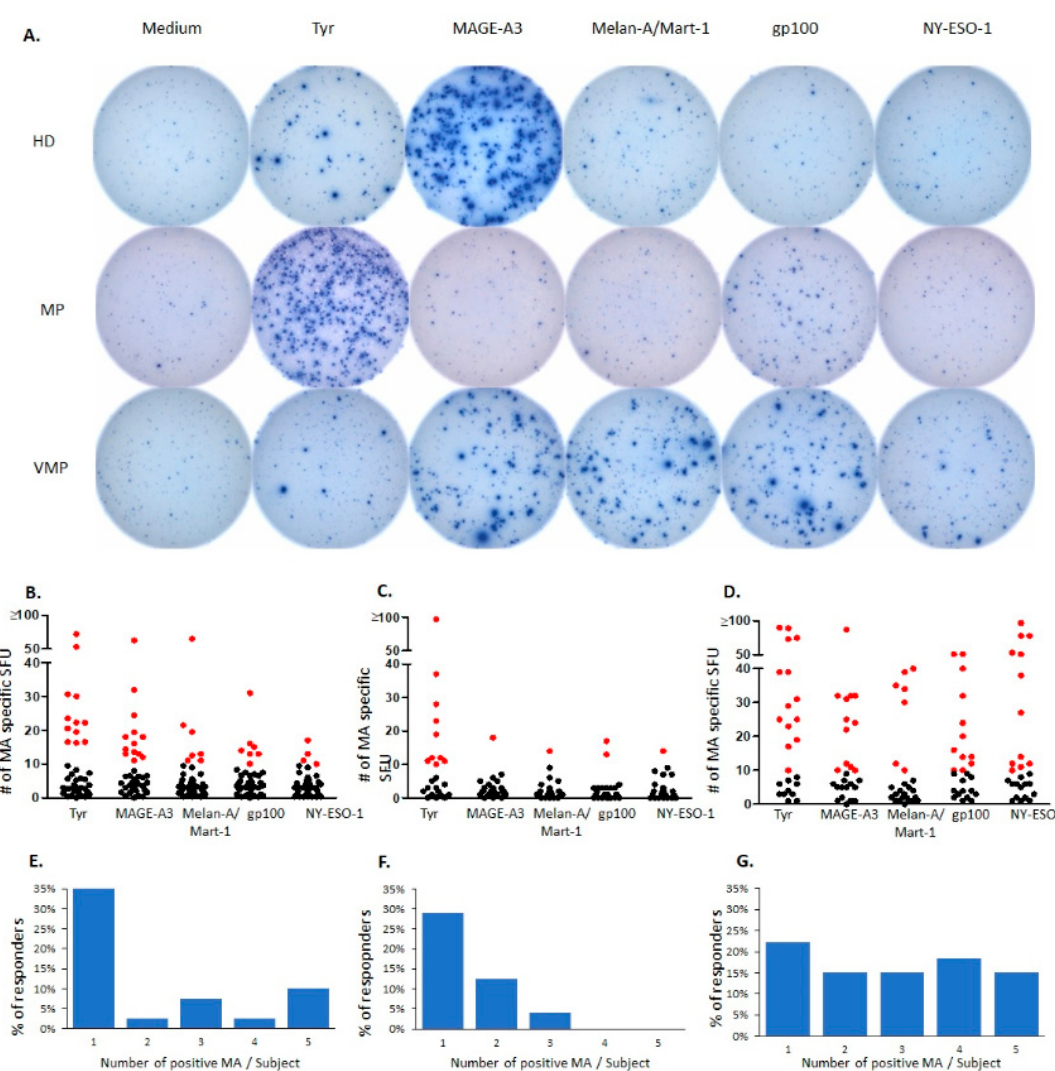
Figure 1. IFN- γ ELISPOT recall responses to melanocyte antigens. ( A ), Representative well images (96-well plate). The melanocyte antigens (MA) specified across the top were tested on PBMC of healthy donors (HD), untreated melanoma patients (MP), and MP vaccinated with AGI-101H (VMP). Well images are shown for a subject representative of each cohort. ( B – D ): The number of MA-specific CD8+ T cells in PBMC of 40 HD ( B ), 24 MP ( C ), and 27 VMP ( D ). For each subject, the IFN- γ ELISPOT recall response was tested after exposing the PBMC to the melanocyte antigens specified on the X-axis. Each data point represents the mean SFU count established in 250,000 PBMC/well, in triplicate wells. Positive T cell responses, as defined in Materials and Methods, are highlighted in red. ( E – G ): The number of MA eliciting positive T cell responses in 40 HD ( E ), 24 MP ( F ), and 27 VMP. PBMCs of each subject were tested in an IFN- γ ELISPOT assay for T cell reactivity to the five MA: Tyrosinase, MAGE-A3, Melan-A/Mart-1, gp100, and NY-ESO-1. The number of MA that elicited a positive response per donor (X-axis) is shown vs. the percentage of subjects in each cohort responding to that number of MA, specified on the Y-axis.